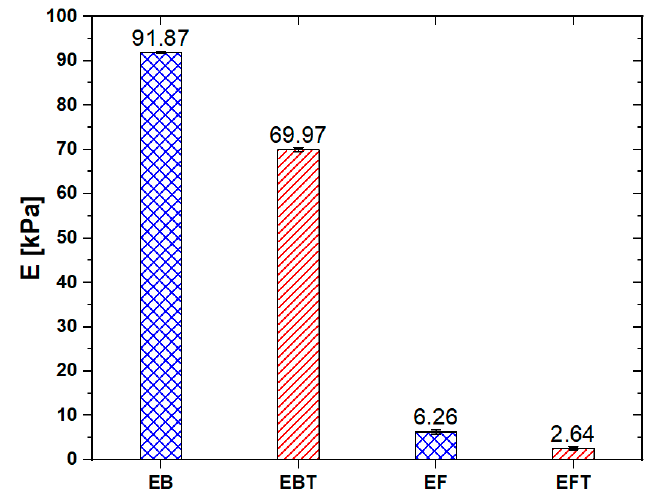
Figure 6. Compressive Young’s modulus of the Ecoflex ® bulk (EB) and EF